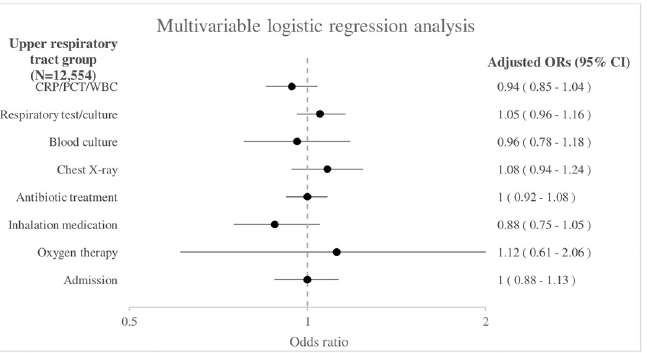
Fig 2. Association between sex and management in the upper respiratory tract group (N = 12,554). Boys as reference group. Adjusted for age, triage urgency, ill appearance, tachypnea, tachycardia, hypoxia, work of breathing, duration of fever, ED.